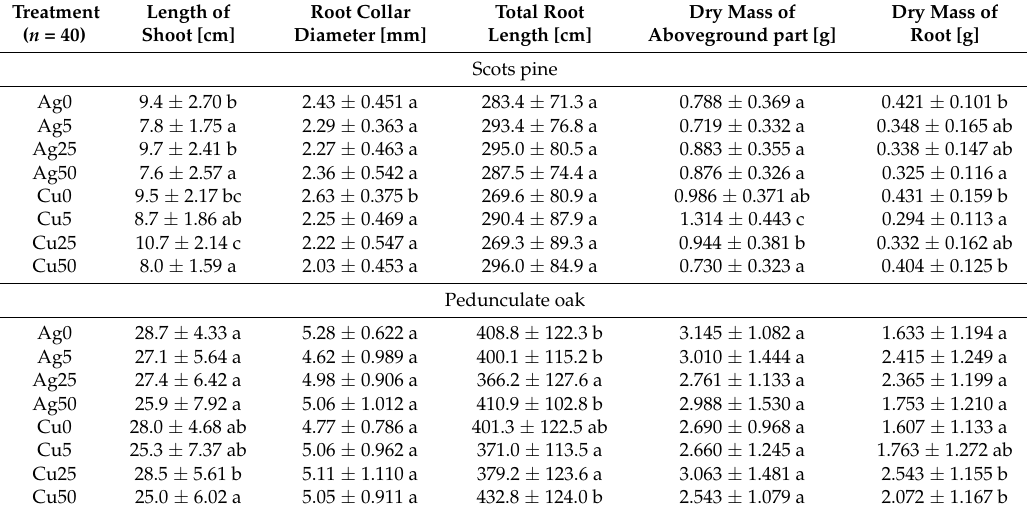
Table 1. Biometric parameters (mean ± SD) describing one-year-old Scots pine and pedunculate oak seedlings treated with different concentrations of AgNPs and CuNPs. Ag0, Cu0—0 ppm; Ag5, Cu5—5 ppm; Ag25, Cu25—25 ppm; Ag50, Cu50—50 ppm. Different letters indicate